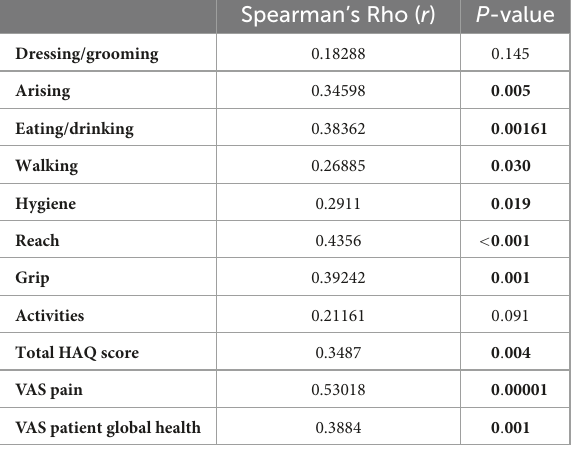
TABLE 2 Correlations between tender joints on clinical examination versus total HAQ score, singular domains of HAQ, VAS pain and VAS PGH are